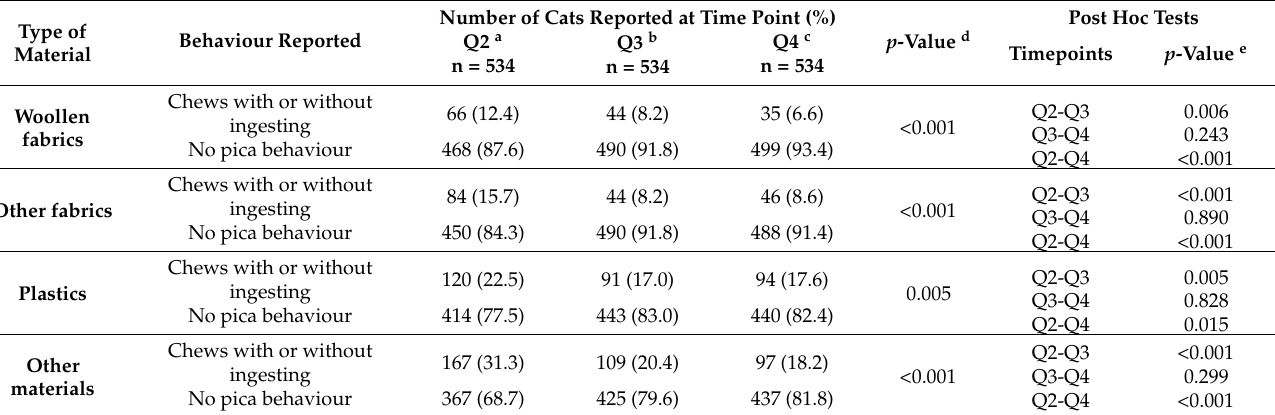
Table 2. Owner-reported pica prevalence and the results of Cochran’s Q tests and post hoc McNemar tests for differences between behaviour type and the three time points for each material (n = 534).